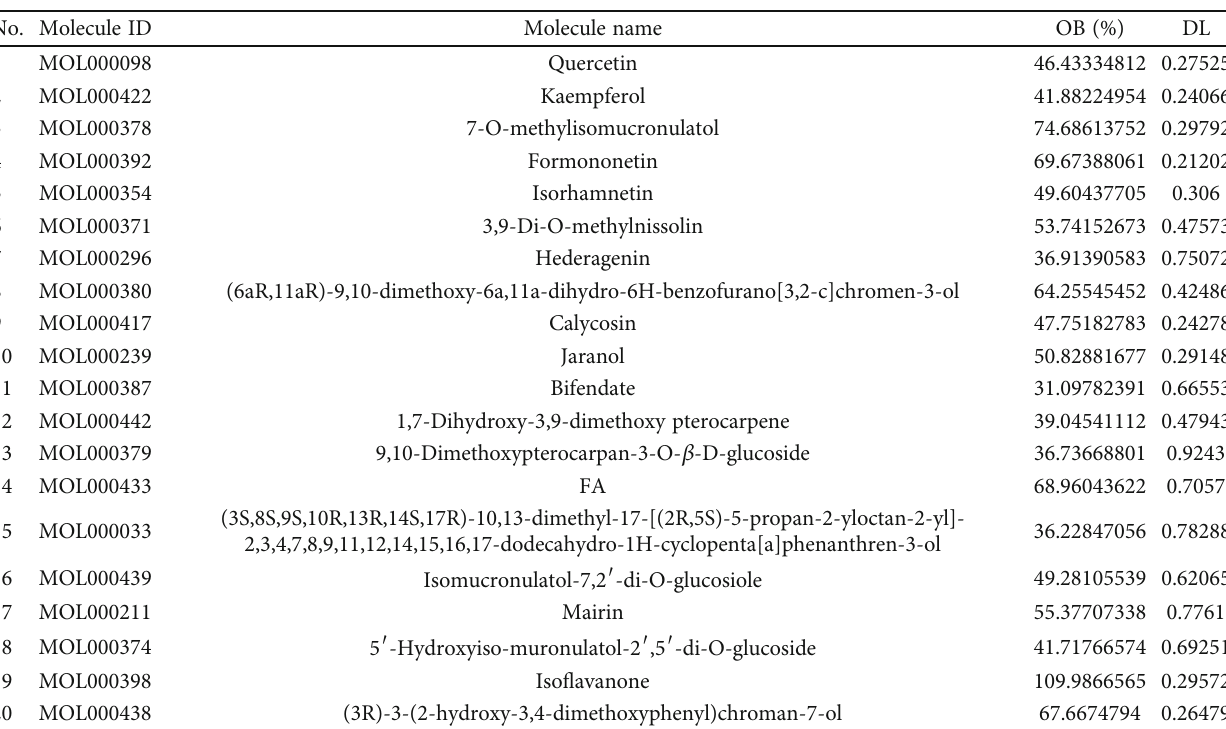
Table 2: Characteristics of active ingredients in